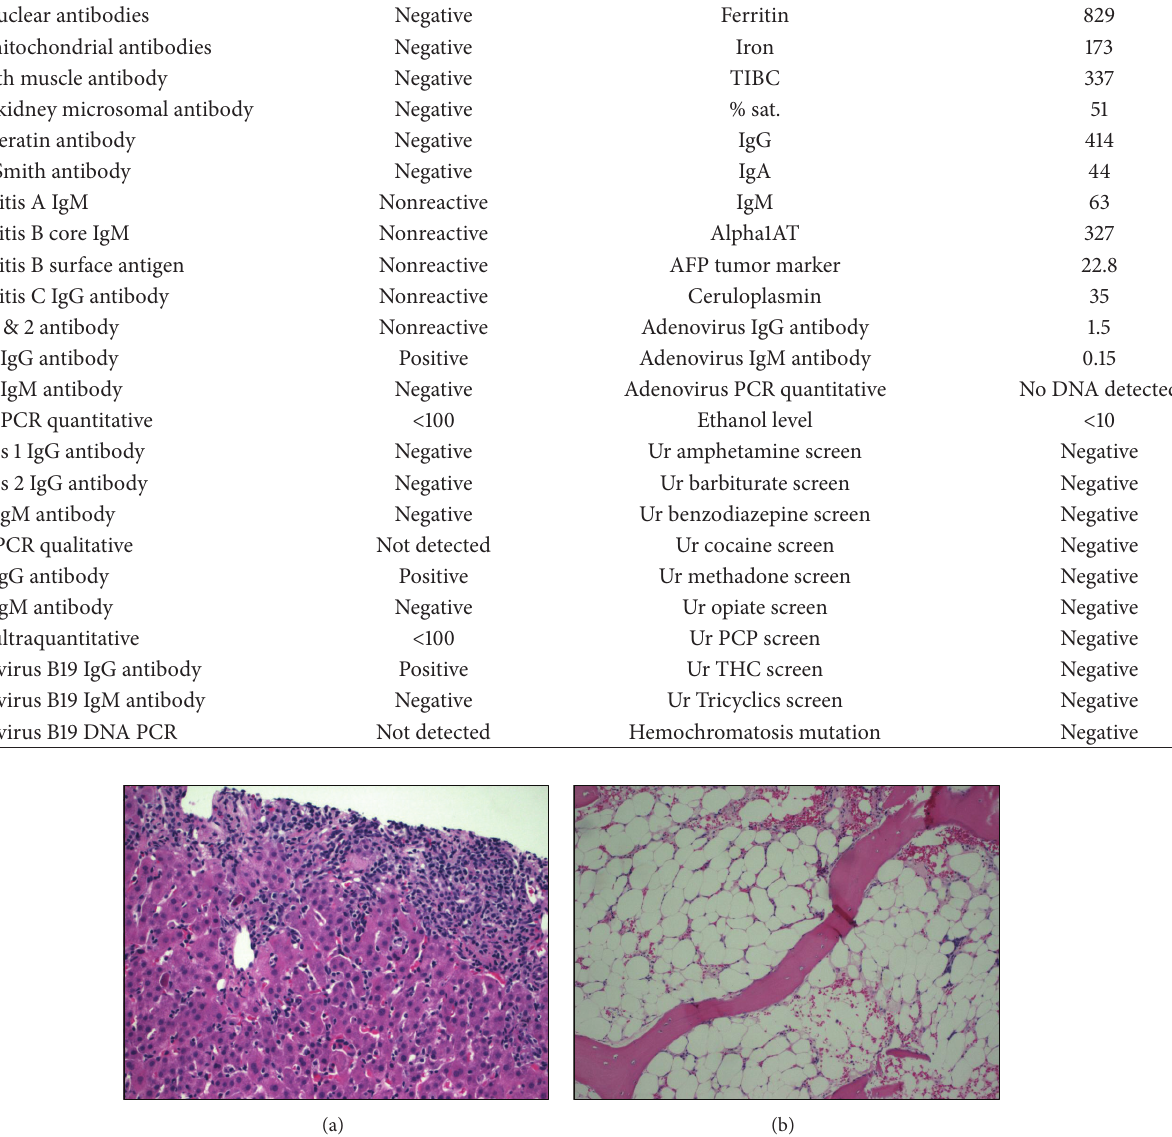
Table 2: Initial acute hepatitis workup.